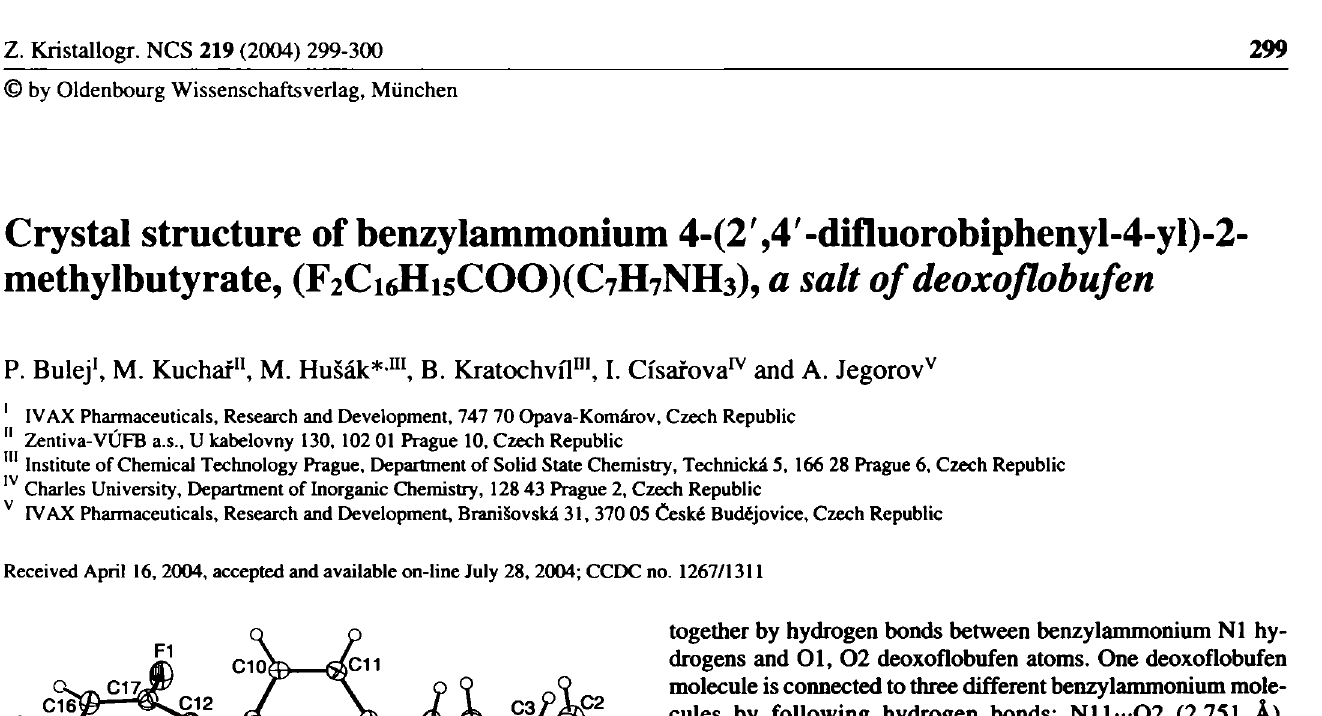
Table 1. Data collection and handling.